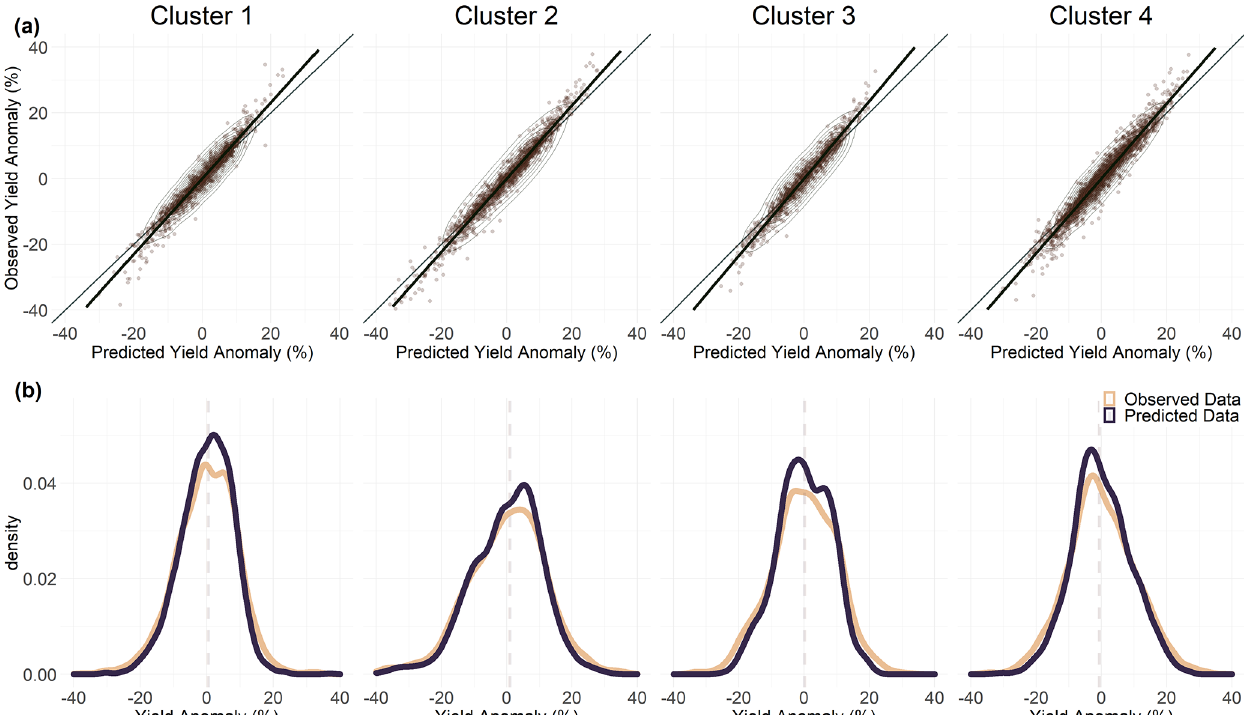
Figure 3. Scatter (a) and density (b) plots of the observed and predicted data for the four clusters derived using the PAM algorithm with size 4. The bold black lines in the scatterplots indicate the linear regression line and the ellipses represent the contours of a 2-D density estimate of the